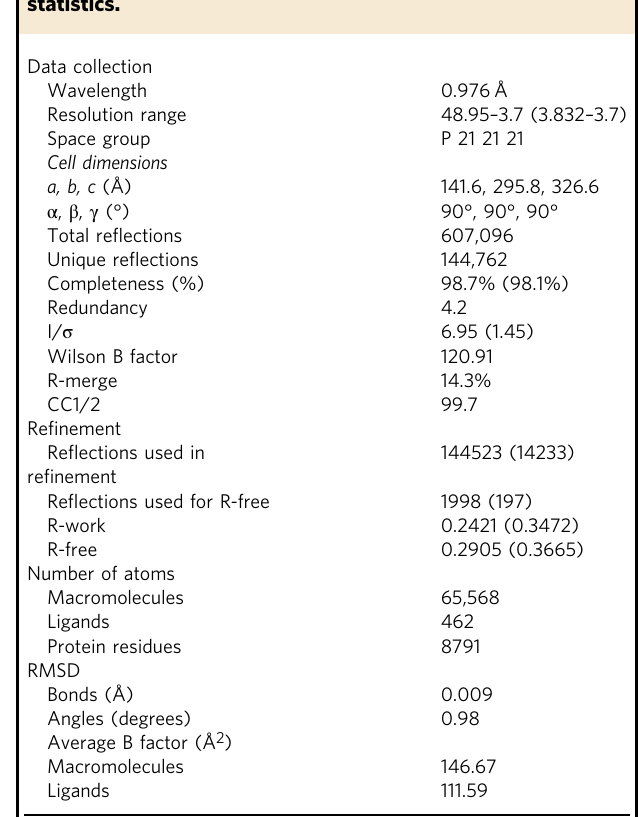
Table 2 Crystallographic data collection and re fi nement